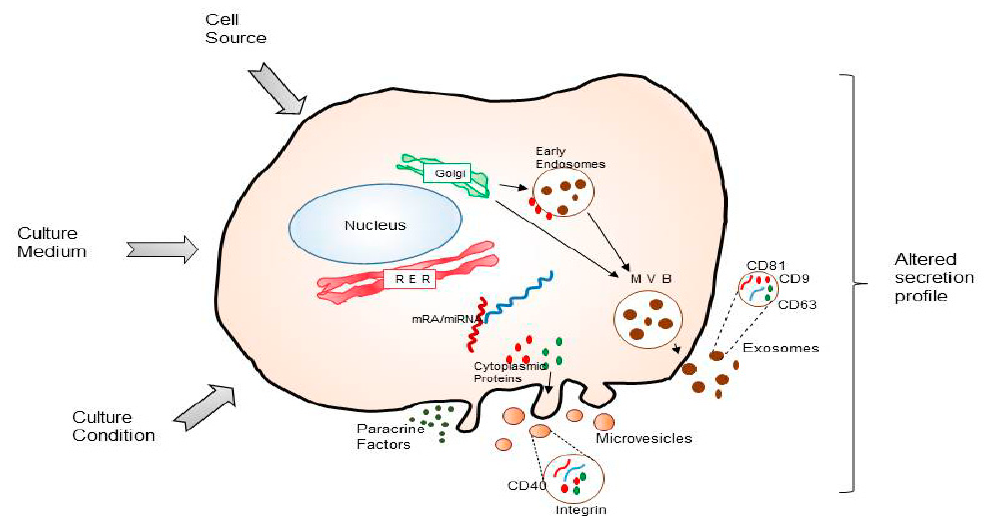
Figure 2. Factors related to bioprocess development (cell source, culture medium and culture conditions) which may influence the quality of MSC secretome-derived products (paracrine factors, microvesicles or exosomes).